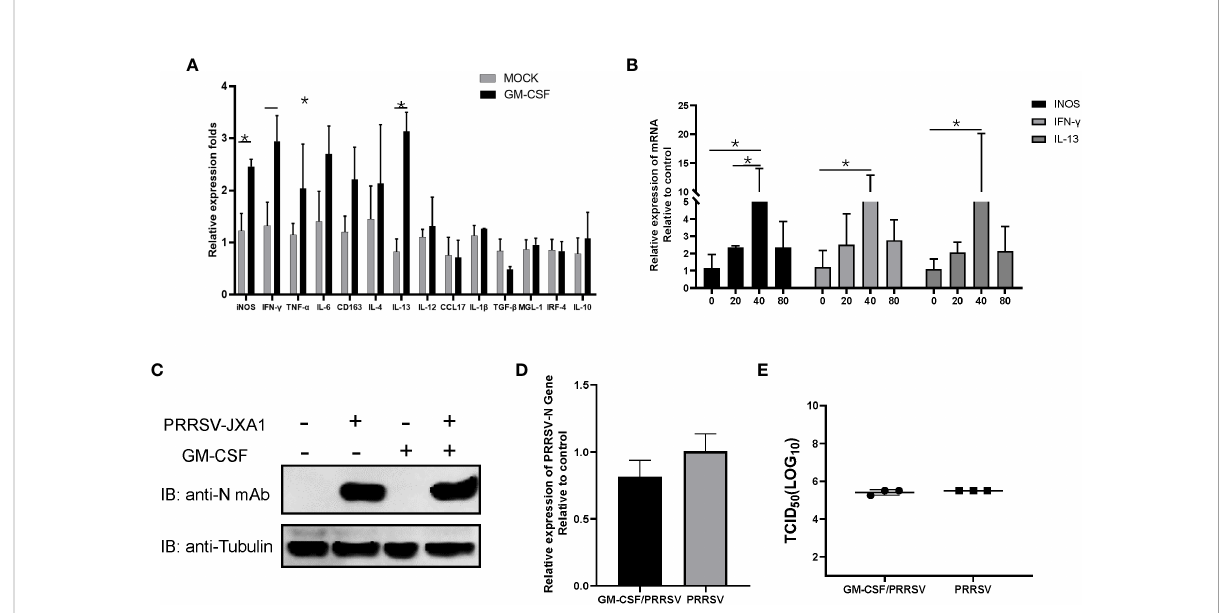
FIGURE 3 The pGM-CSF cannot inhibit PRRSV replication in PAMs in vitro . (A) PAMs were either treated with 40ng recombinant pGM-CSF for 24 hours or left untreated (MOCK). Next, PAMs were harvested by TRIzol agent and reverse transcribed. The mRNA level of indicated genes was evaluated using qPCR. Experiments were repeated for at least three times. All data are expressed as mean ± SD and were subjected to Student ’ s t-test. Signi fi cant differences between indicated groups are marked by “ * ” ( p < 0.05). (B) PAMs were treated with different dose of recombinant pGM- CSF for 24 hours or left untreated (0ng). Next, PAMs were harvested by TRIzol agent and reverse transcribed. The mRNA level of iNOS, IFN- g and IL-13 was evaluated using qPCR. Experiments were repeated for at least three times. All data are expressed as mean ± SD and subjected to Student ’ s t -test. Signi fi cant differences between indicated groups are marked by “ * ” ( p < 0.05). (C) PAMs were either treated with 40ng recombinant pGM-CSF protein for 24 hours or left un-treated (MOCK) before inoculated with PRRSV-JXA1 strains (0.1 MOI) for additional 24 hours. PAMs were harvested for SDS-PAGE followed by western blotting assay use anti-PRRSV-N speci fi c mAb-6D10. Tubulin was probed from the same membrane as a loading control. (D) PAMs were either treated with 40ng recombinant pGM-CSF protein for 24 hours or left un- treated (MOCK) before inoculated with PRRSV-JXA1 strains (0.1 MOI) for additional 24 hours. Next, PAMs were harvested by TRIzol agent and reverse transcribed for evaluating PRRSV-RNA level using qPCR. Experiments were repeated for at least three times and presented as mean ± SD. (E) PAMs were either treated with 40ng recombinant pGM-CSF protein for 24 hours or left un-treated (MOCK) before inoculated with PRRSV-JXA1 strains (0.1 MOI) for additional 24 hours. Next, cell culture supernatant of PAMs were harvested for PRRSV titration and determined as TCID 50 . Experiments were repeated for at least three times and presented as mean ±